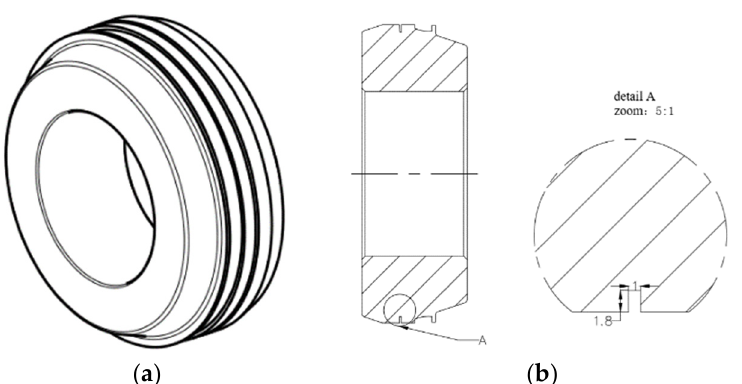
Figure 3. Annular narrow slot geometric model. ( a ) Integral structure of winding wheel; ( b ) Narrow slot structure and magnification diagram.